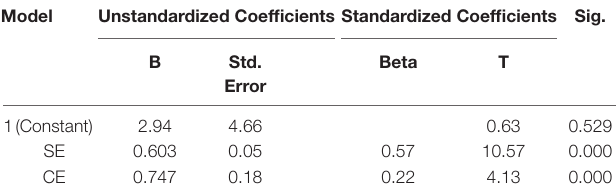
TABLE 8 | Coefficients for WE, SE, and CE.